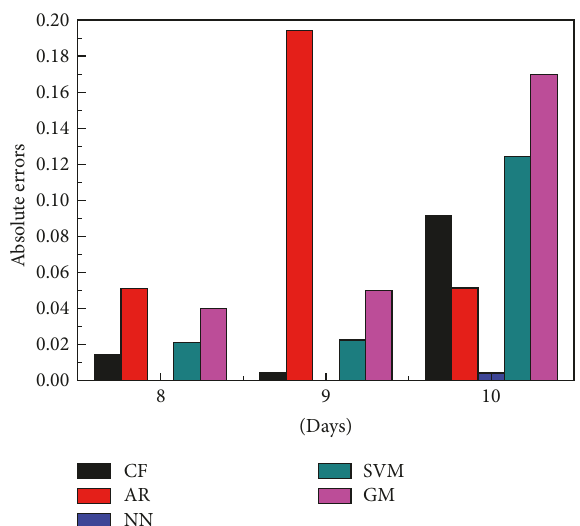
Figure2:Theabsoluteerrorbetweentheactualandpredictedvalues for the first